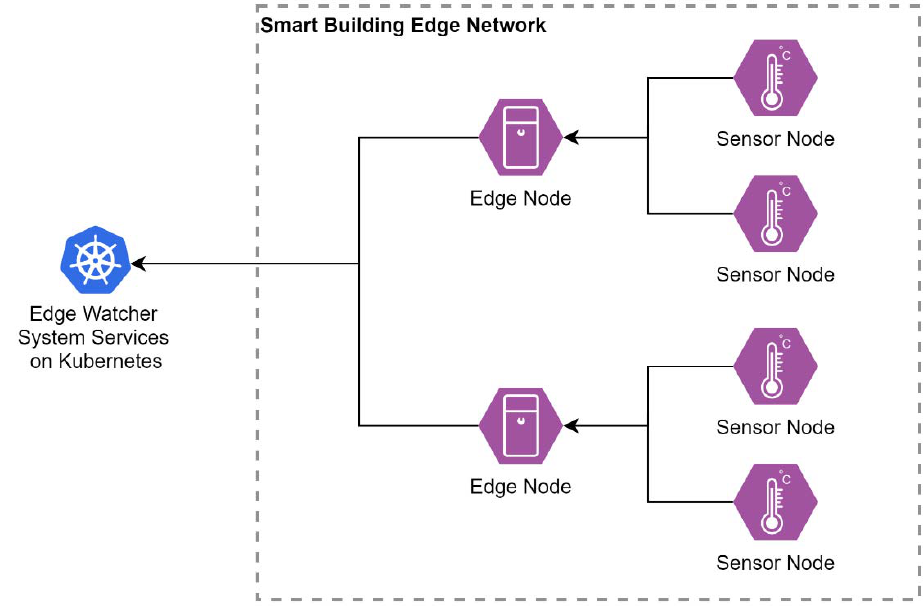
Figure 3. EWS design with edge nodes.